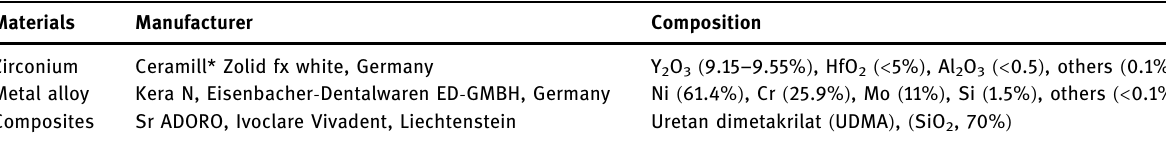
Table 1: Chemical composition of starting materials